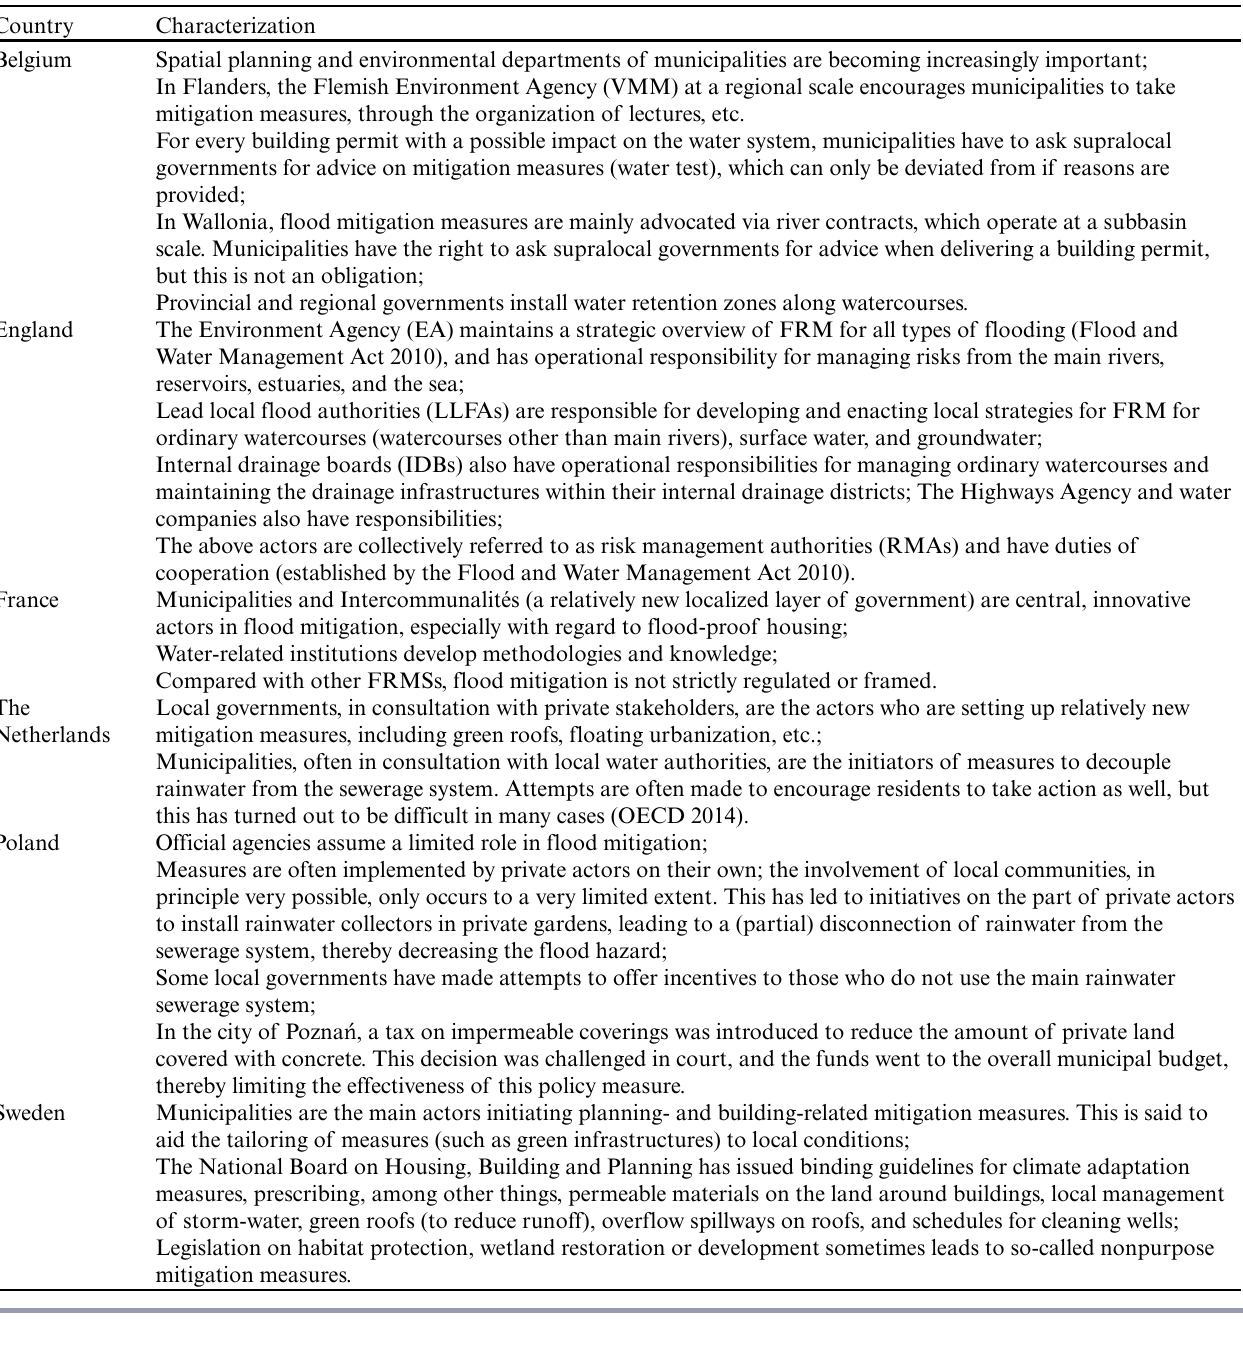
Table 3 . Characterization of the six researched countries on the degree to which local and/or multilevel governance is present. Country